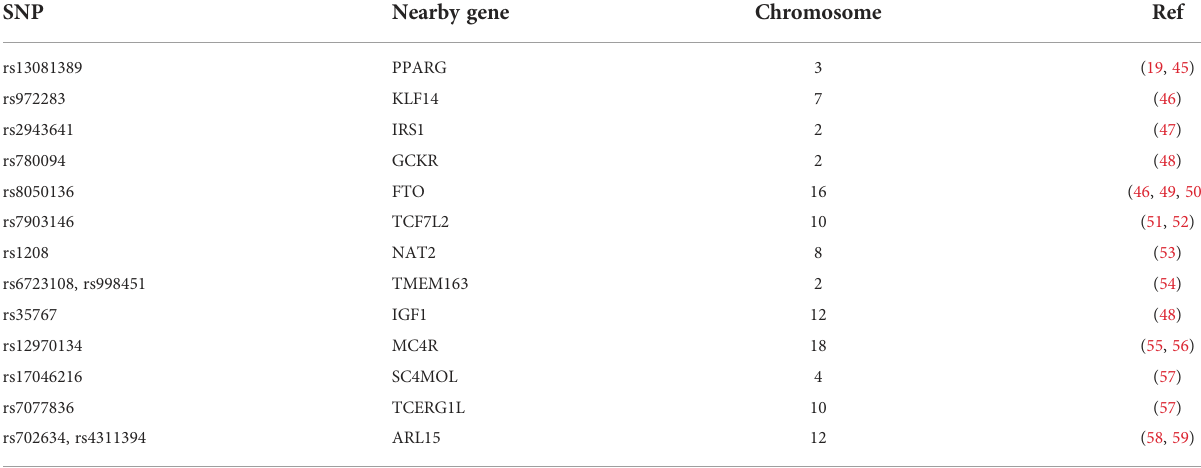
TABLE 1 Variants associated with IR. Adapted from Brown and Yanovski (17)